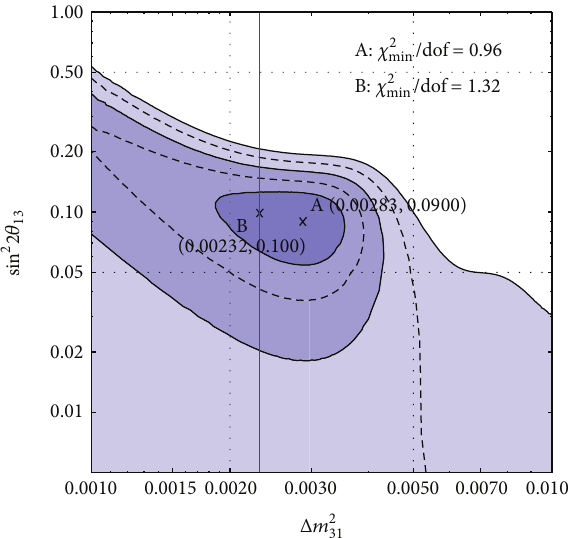
Figure 4: Three-neutrino analysis of the spectral shape updated until October 2012. The best fit in (Δ𝑚 2 31 , sin 2 2𝜃 13 ) is (0.00283, 0.09) denoted by A. When Δ𝑚 2 31 = 0.00232 eV 2 is fixed as taken by RENO, the best fit of sin 2 𝜃 13 is 0.100. The 1𝜎, 2𝜎 , and 3𝜎 exclusion curves are drawn by solid lines.